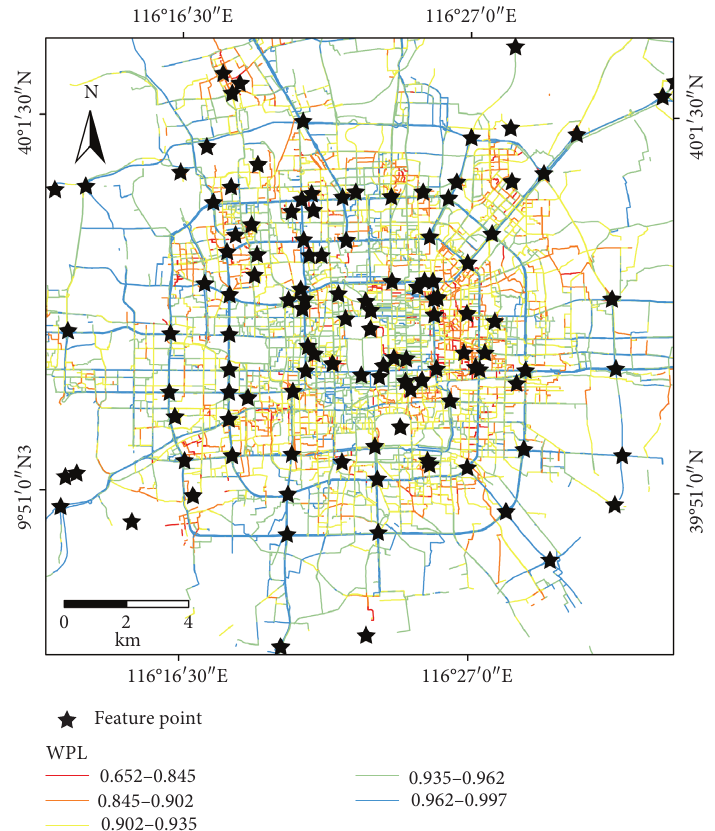
Figure 7: Distribution of some of the feature